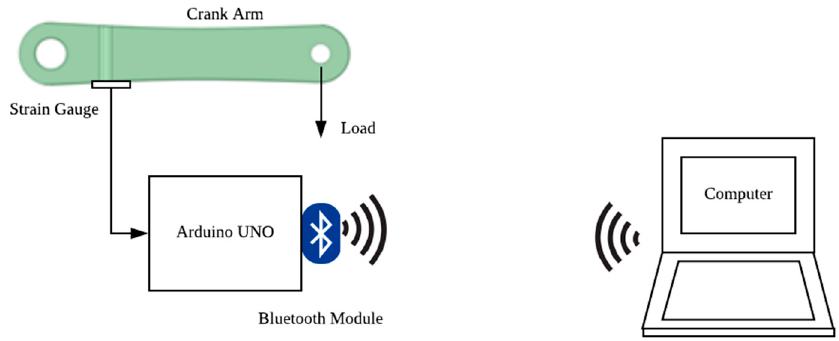
Figure 6. Experimental setup.